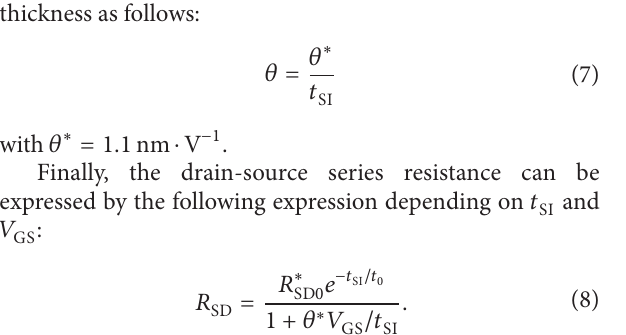
Figure 7: plot of theta versus the four channel